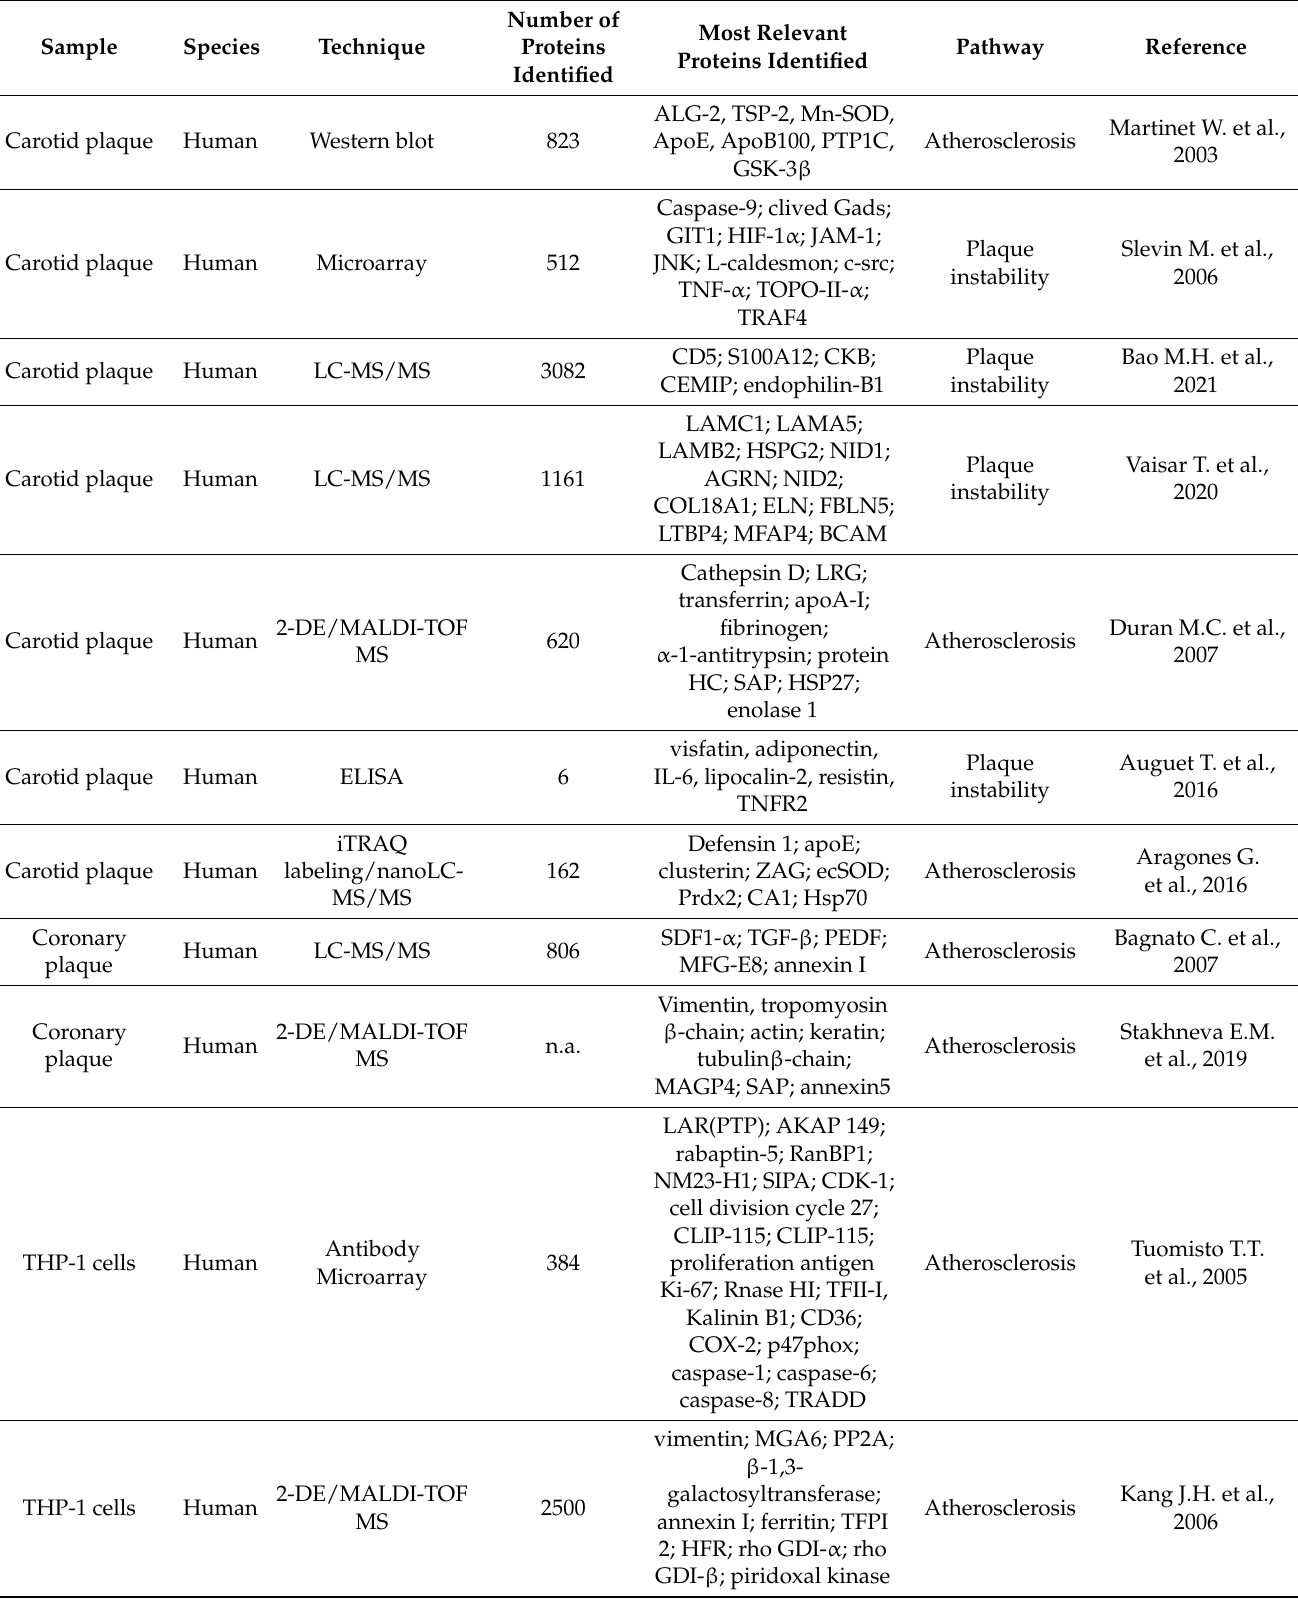
Table 3. Summary of proteomic studies performed on human